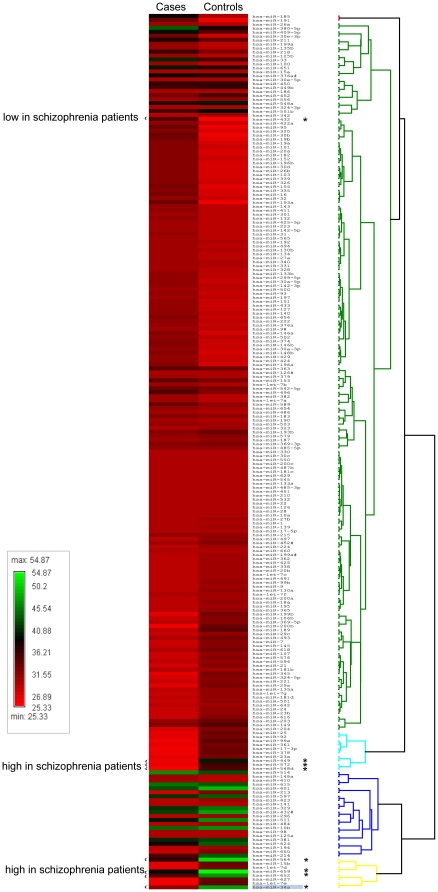
miRNA expression profiling of 221 miRNAs in the learning set of 30 schizophrenia patients and 30 controls.The heatmaps of individual miRNAs for each group of subjects were presented as the averaged rank-sum of the normalized threshold cycle number, with less numbers indicating higher expression levels. The eight differentially expressed miRNAs were marked by an asterisk.